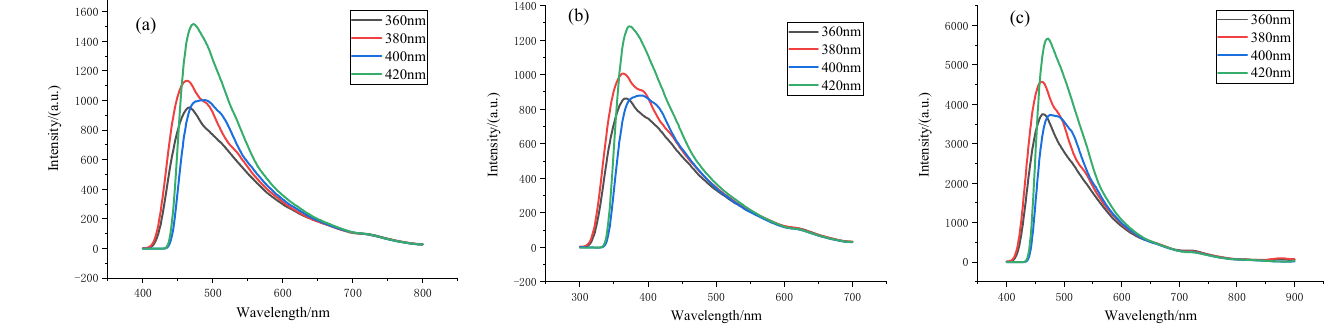
Figure 6. Fluorescence spectra of spherical carbon nanostructures at three temperatures: ( a ) spherical carbon nanostructures at 500 °C; ( b ) spherical carbon nanostructures at 600 °C; ( c ) spherical carbon nanostructures at 800 °C.